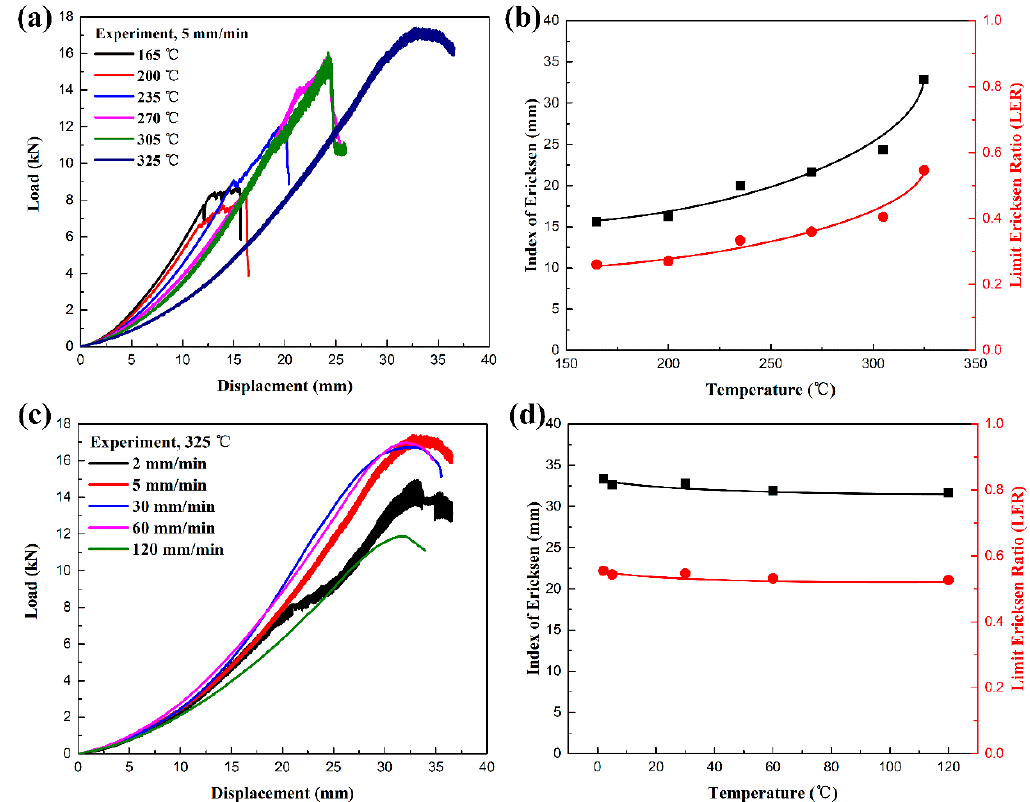
Figure 10. Erichsen forming performance of woven CF/PEEK sheets under different conditions: ( a ) force vs. displacement curve at different temperatures, ( b ) the relationship between IE and LER vs. temperature, ( c ) force vs. displacement curve at different test speed, and ( d ) the relationship between IE and LDR vs. test speed.